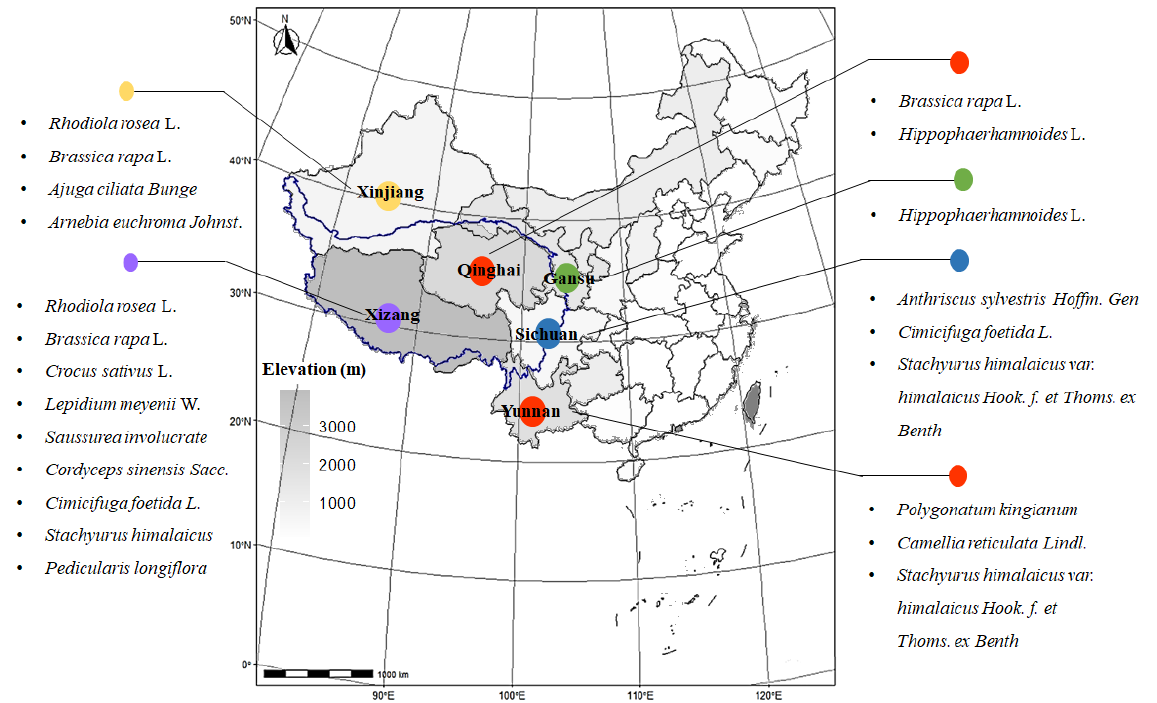
Figure 2. Distribution of high-altitude plants with anti-fatigue effect. Here, 15 representative high- altitude plants with anti-fatigue effect are summarized, which are distributed among the Tibetan Plateau and surrounding mountains (mainly across six provinces). The boundary of the Qinghai– Tibet Plateau in the map is circled in blue (solid line). Color represents average elevation; the darker the color, the higher the area. Table 1. The anti-fatigue effects and main active ingredients from high-altitude plants.